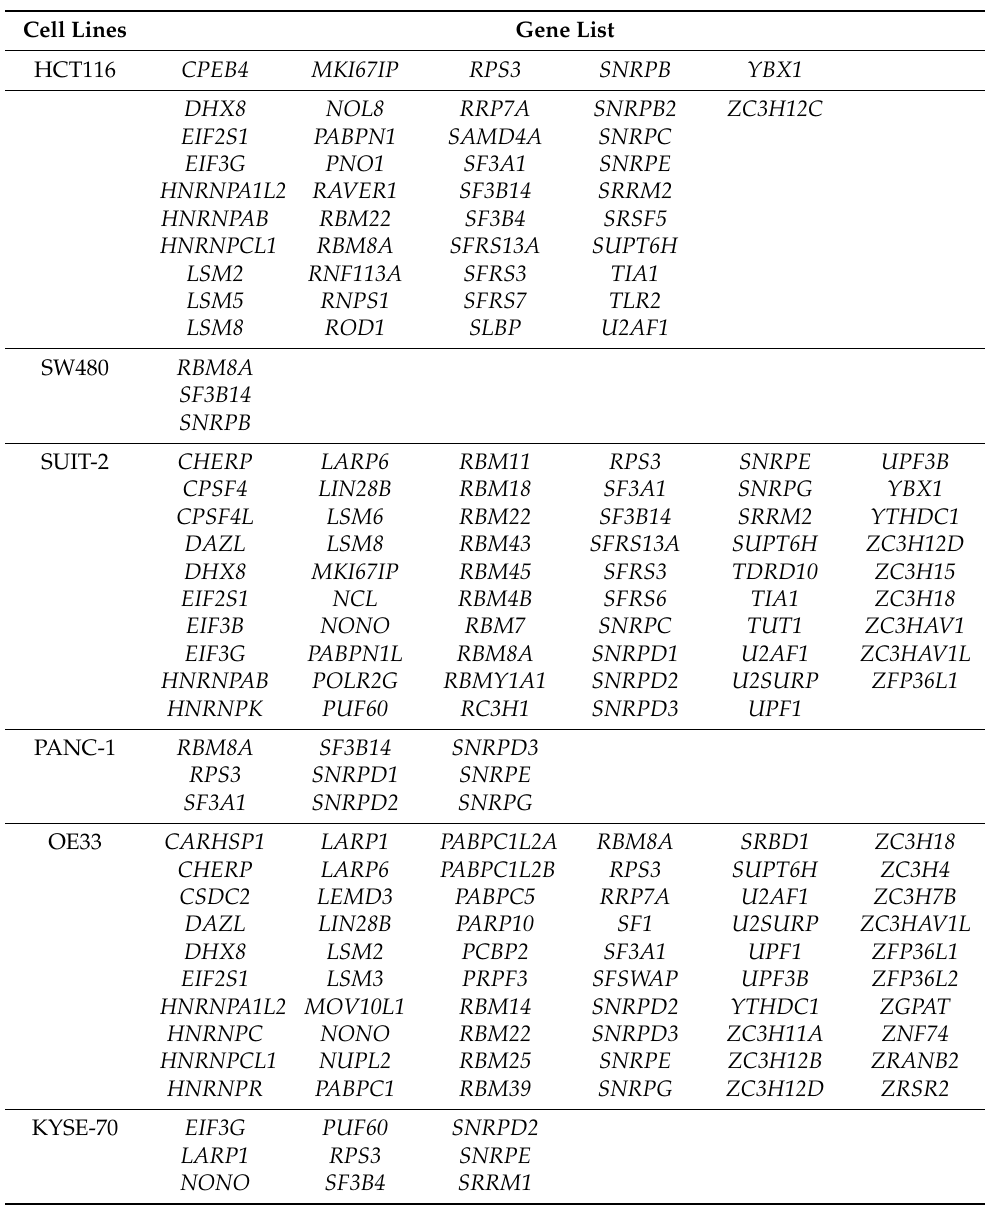
Table 5. The list of tumor-promotive RBPs whose expressional abnormality and mutation were not detected in cancer